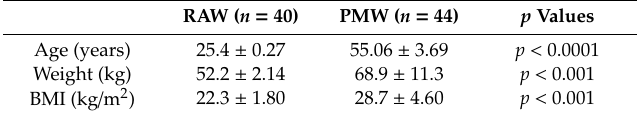
Table 1. Demographic and clinical characteristics of study participants.